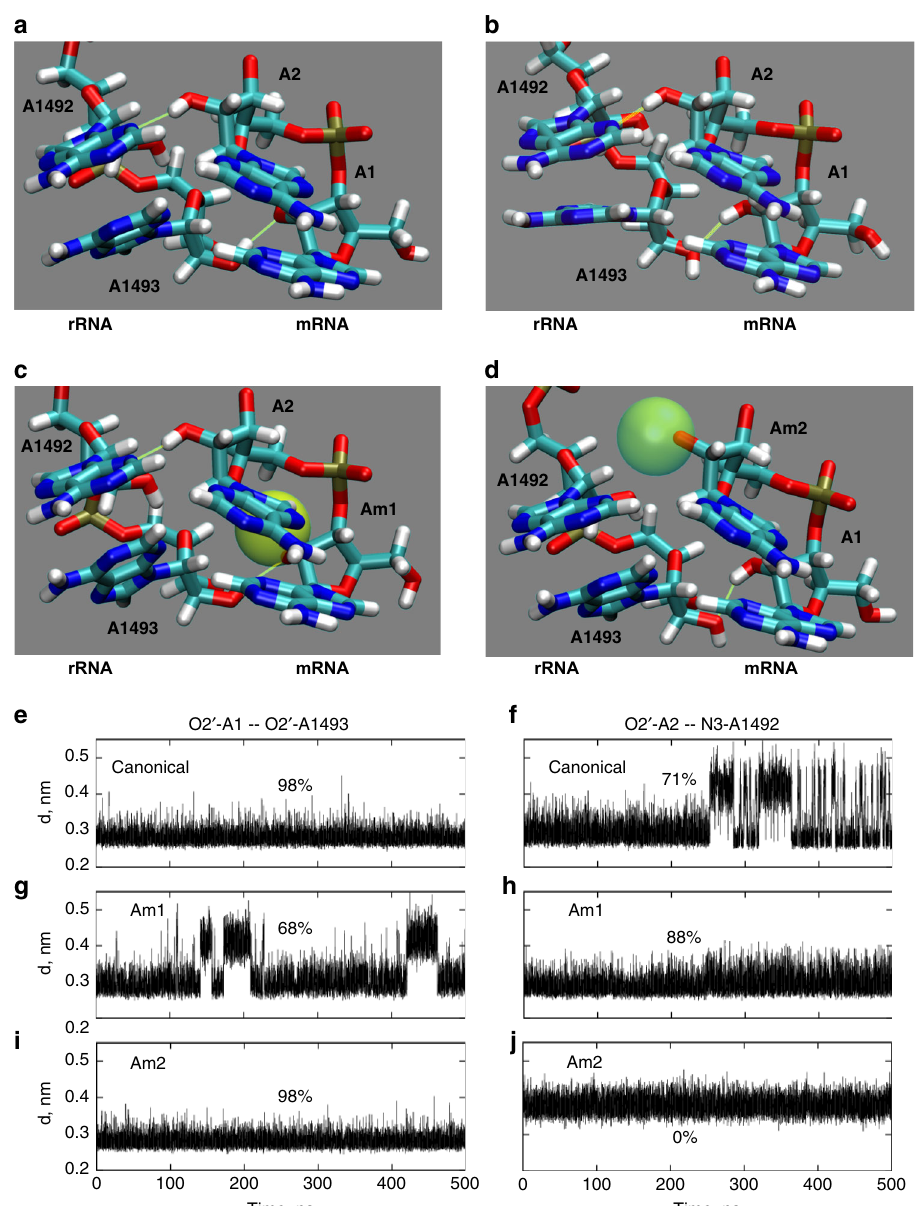
Fig. 5 Molecular dynamics modeling of Pxdn Nm codon modi fi cation at the ribosomal A-site. SnoRNA-guided Nm modi fi cation on Pxdn mRNA is predicted at the fi rst position of an AAG lysine codon. Our model of the ribosomal A-site included the mRNA, tRNA, and rRNA, but only the fi rst two nucleotides of the AAG codon (A1 and A2) and the relevant monitoring rRNA nucleotides (A1492 and A1493) are shown for clarity. Hydrogen bonds are shown as yellow lines. Movies of the full trajectories are available online. a , b Representative con fi gurations of the canonical interaction. For the A1:A1493 interaction, note that A1 can serve as the hydrogen bond donor ( a ) or acceptor ( b ). c , d Representative con fi gurations of the Am1 and Am2 modi fi cations, respectively, where the van der Waals radius for the Nm methyl group is shown as a yellow-green sphere. e – j The A1:A1493 and A2:A1492 donor-acceptor distances are shown for 500 ns simulations. Distances < 0.32 nm are consistent with hydrogen bonding interactions, and the percent of time that each interaction falls within this range are also shown. e , f canonical (unmodi fi ed). g , h Am1 (Am at fi rst codon position). i , j Am2 (Am at second codon Reverse transcription at low dNTP followed by PCR . This procedure was was then calculated for each condition, to normalize the low dNTP result to the amount of Pxdn mRNA in each sample. Finally, this value could be compared adapted from the previously described RTL-P method 25 . cDNA was generated between experimental (KO or FBL KD) conditions as a relative quantity (RQ). This from 500 ng of total RNA, with oligo-dT RT priming, under two conditions: (1) method accounts for changes in transcript methylation relative to transcript standard SuperScript III (ThermoFisher) reverse transcriptase reaction (1 mM abundance in normal conditions. dNTP mix), and (2) under the same conditions except low dNTP concentration (0.1 mM dNTP mix). qPCR was then performed in 20 μ L reactions with Power SYBR, 0.25 µM forward and reverse primers (both 5 ′ to the putative Nm site, as shown in Fig. 1d and detailed in Supplementary Table 1), and 2 μ L of each cDNA with a hot start (95 C; 10 ′ ) and 40 cycles of 95 C (15 s) and 60C (1 ′ ). Relative quanti fi cation of Pxdn from each cDNA reaction (both high and low dNTP) was fi rst normalized to an internal reference gene ( Rplp0 ) to correct for any differences in total RNA input (standard ddCT method). The ratio of low/high dNTP product